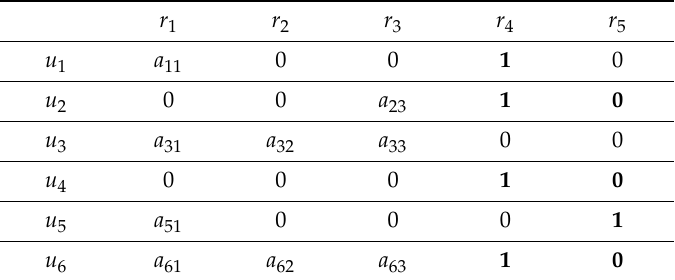
Table 13. Assignments in step 2.